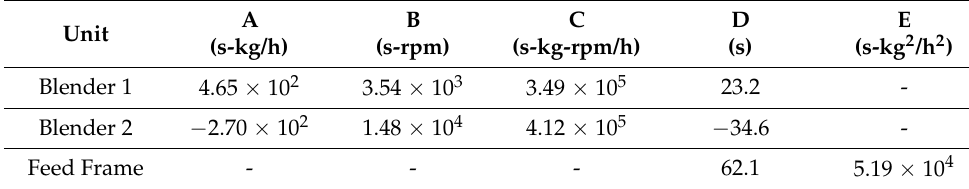
Figure 12. Funnel plots for Blender 1 at various flow rate and blade speed conditions.